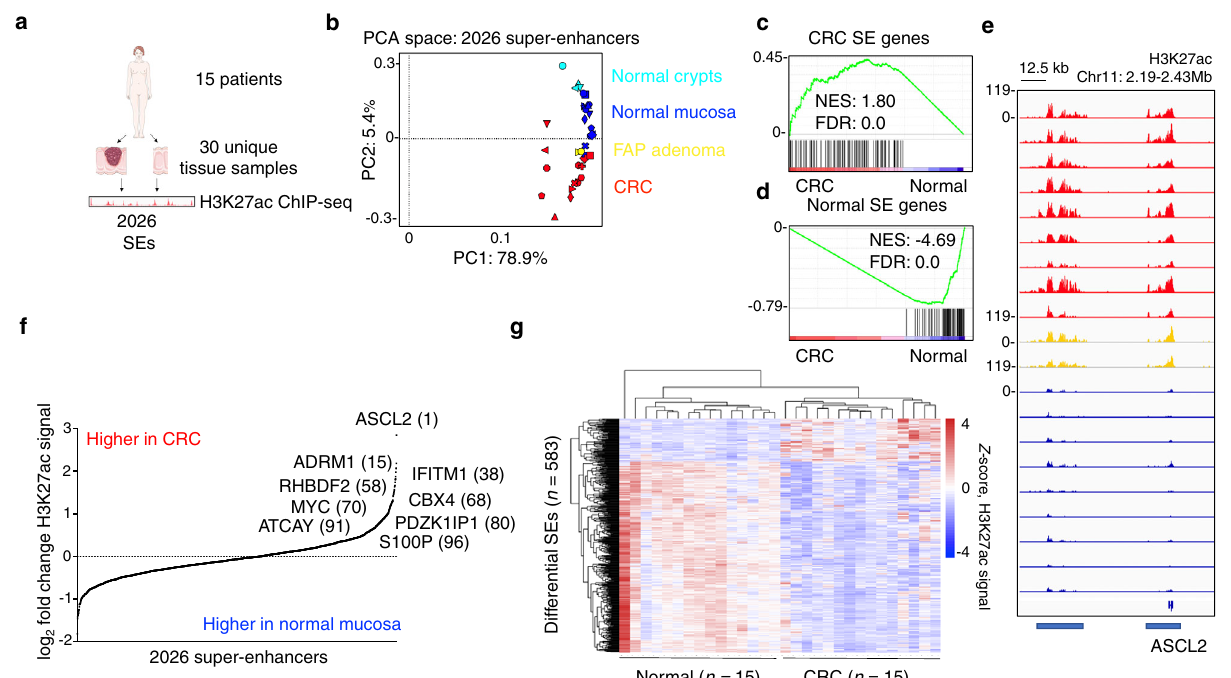
Fig. 1 | Recurrently dysregulated super-enhancers in CRC patients. a Study overview. Figure adapted from SMART Servier Medical Art, reproduced with per- mission, licensed under a Creative Commons Attribution 3.0 unported license. b PCA of H3K27ac signal at 2026 SEs in CRC ( n =15 independent tissue samples), normal mucosa ( n =15), crypts ( n =4), and FAP adenomas ( n =2). c , d GSEA between SE proximal genes and differentially expressed genes between CRC and